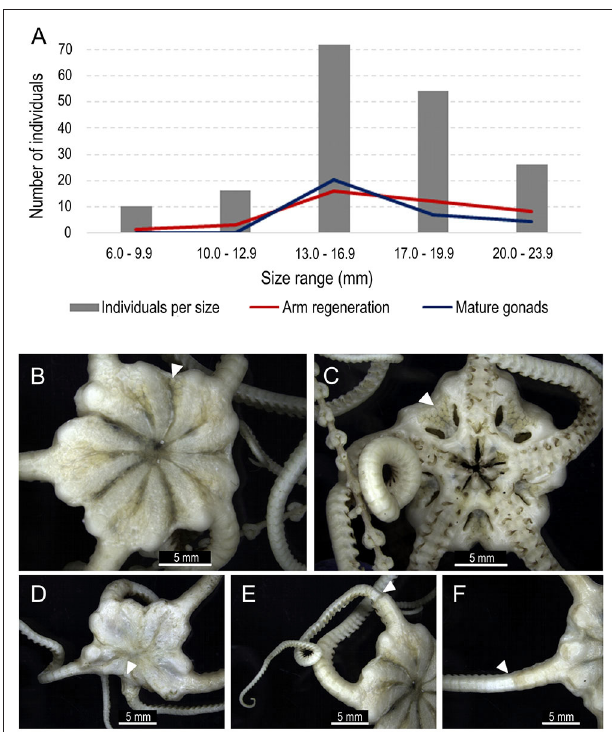
FIGURE 3 | Astrodia cf. excavata biological information. (A) Plot of number of individuals per size range, number of individuals showing evidence of arm regeneration, and mature gonads (B,C) Dorsal and ventral view showing mature gonads by direct observation. (D) Evidence of disc regeneration. (E,F) Evidence of arm